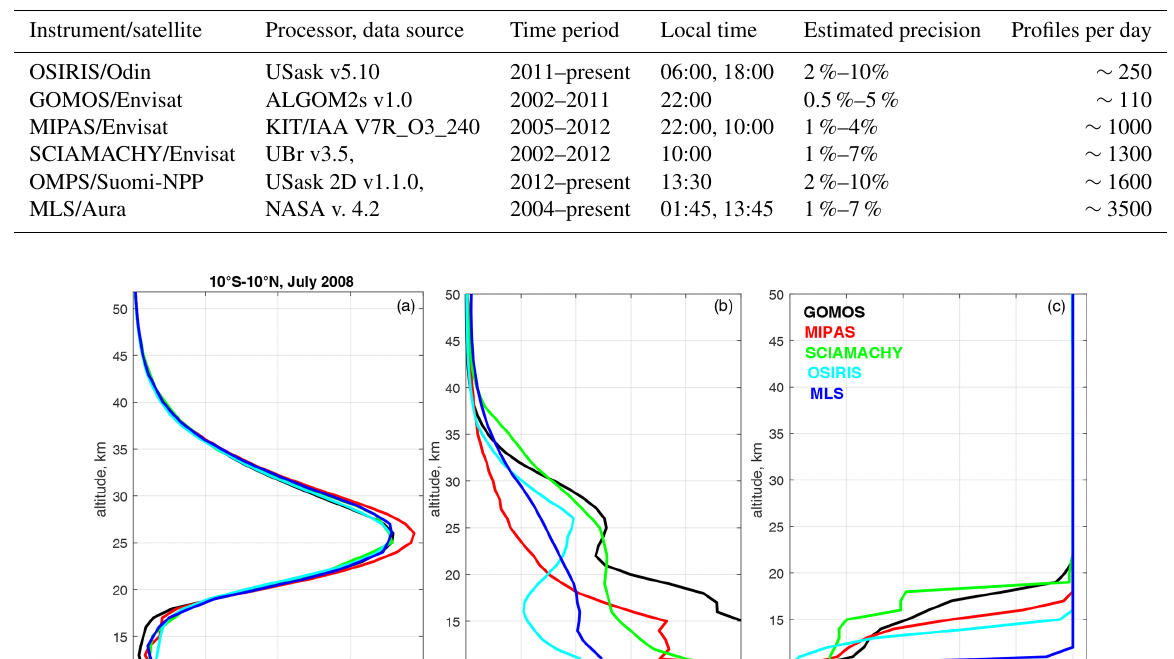
Table 1. Information about the datasets used in the analyses.